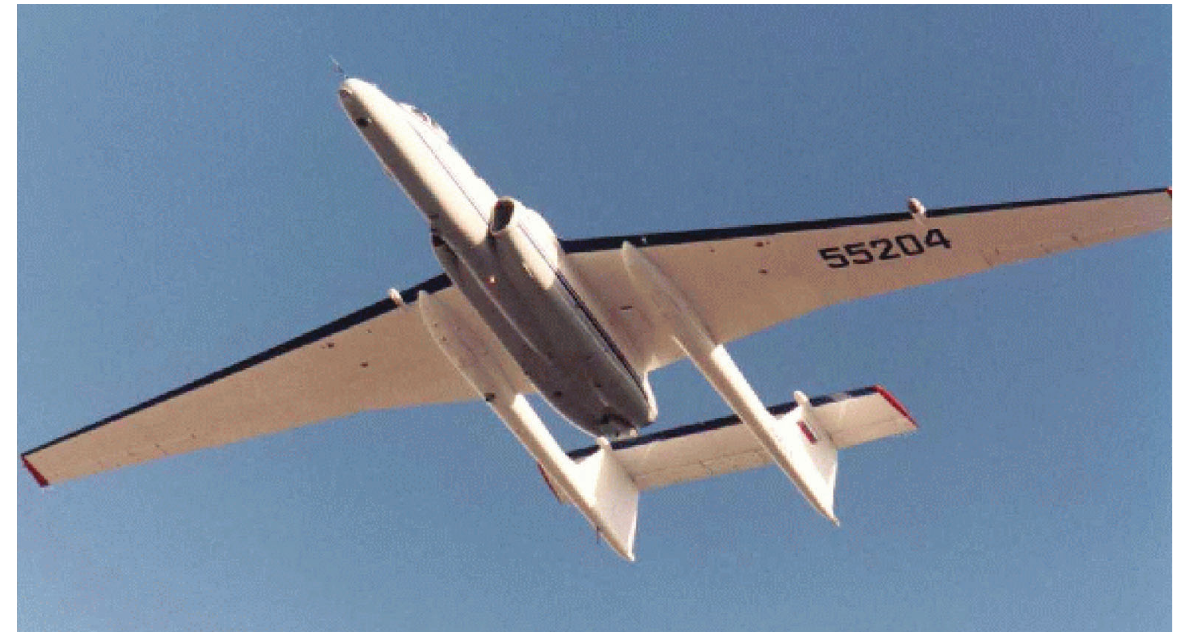
Fig. 4. The Myasischev M-55 Geophysica stratospheric aircraft.